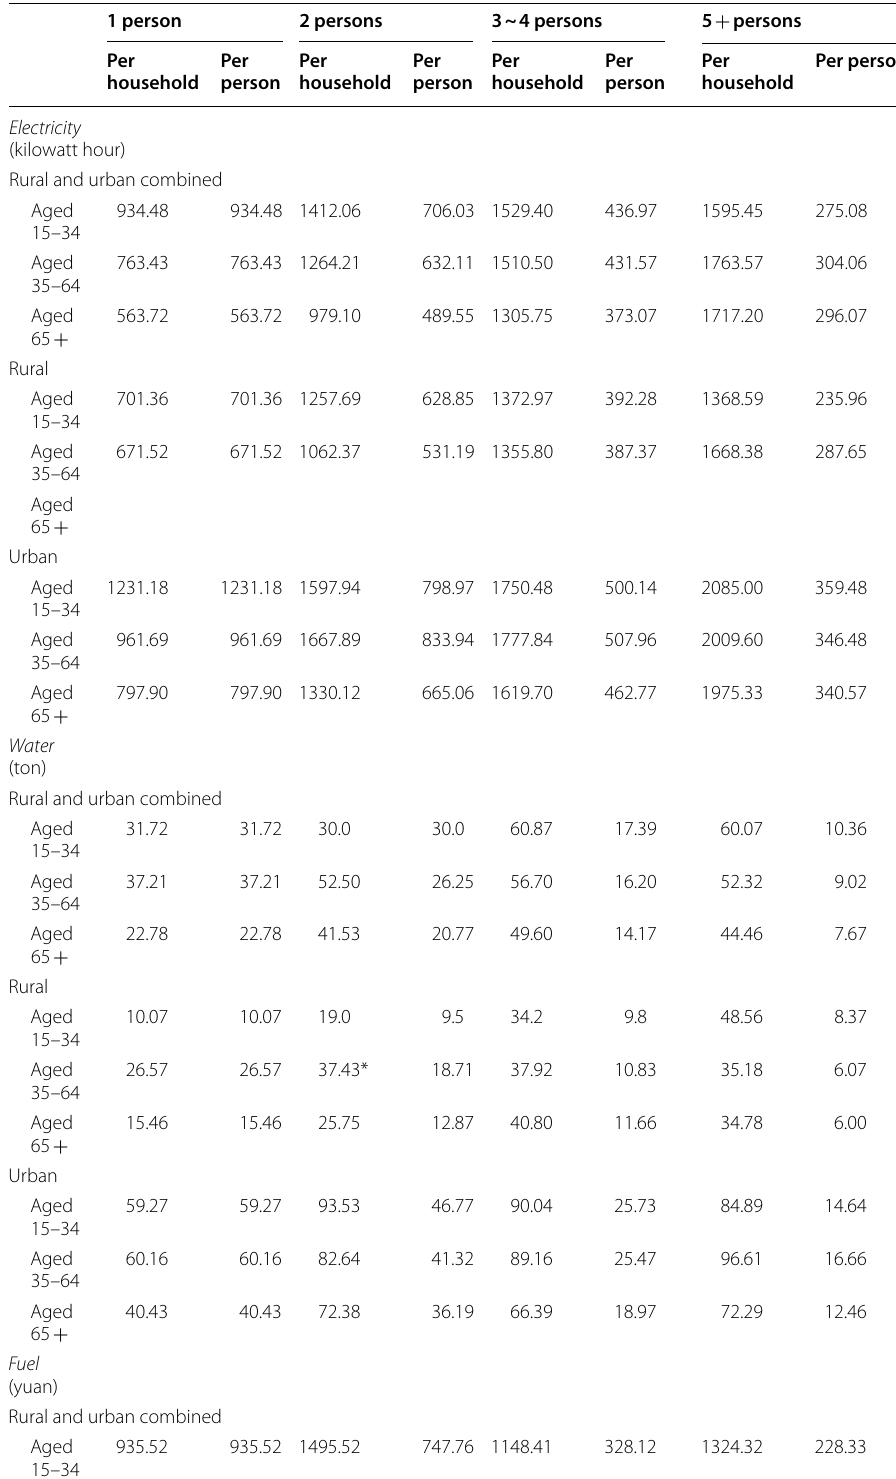
Table 1 Average residential energy consumption per household and per person by rural/urban, household size and ages of householders, Hebei province, China,